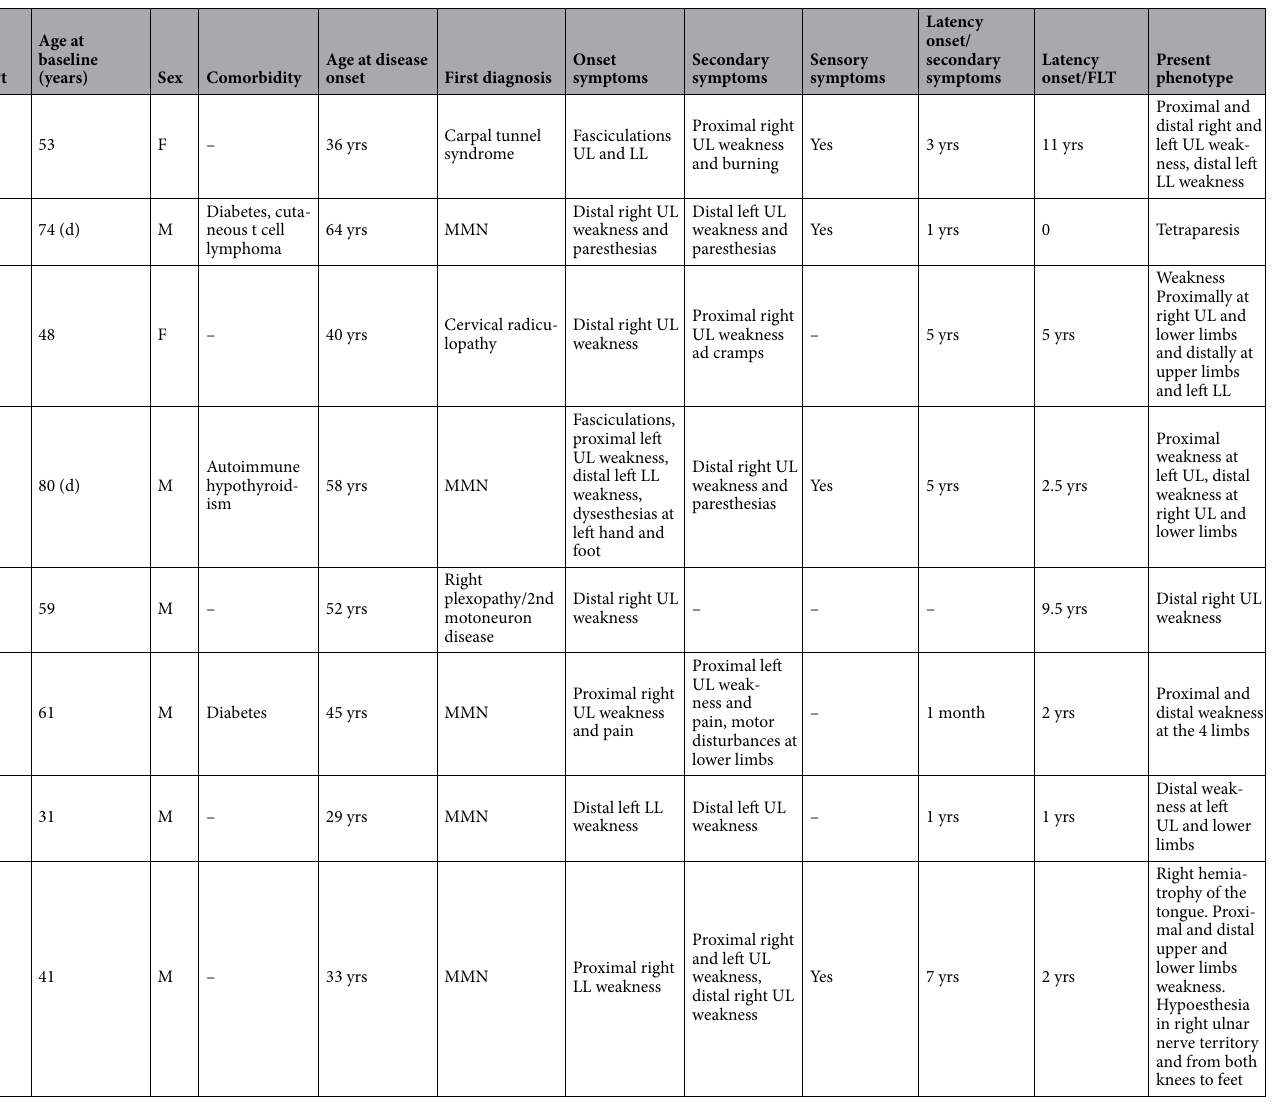
Table 1. Clinical and demographic characteristics of MMN patients. Pt patient, (d) dead, – not applicable. Yrs years, MMN multifocal motor neuropathy, UL upper limb, LL lower limb, FLT first line